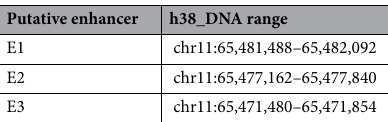
Table 1. MALAT1 putative enhancer